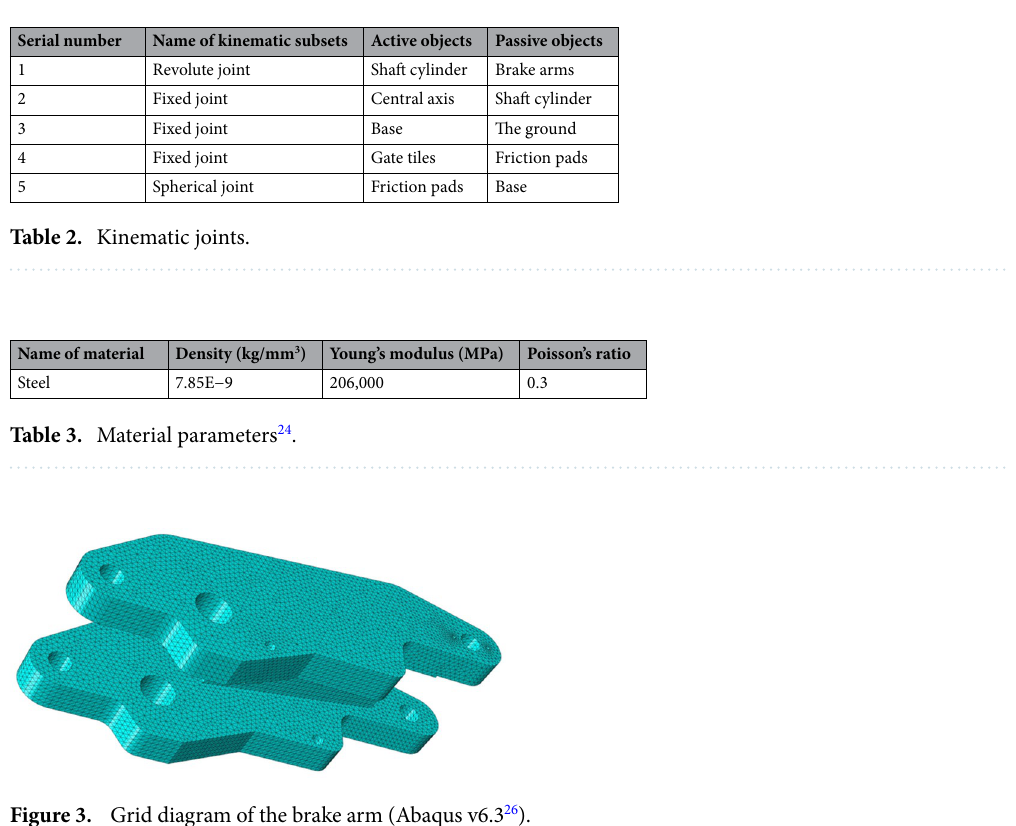
Figure 3. Grid diagram of the brake arm (Abaqus v6.3 26